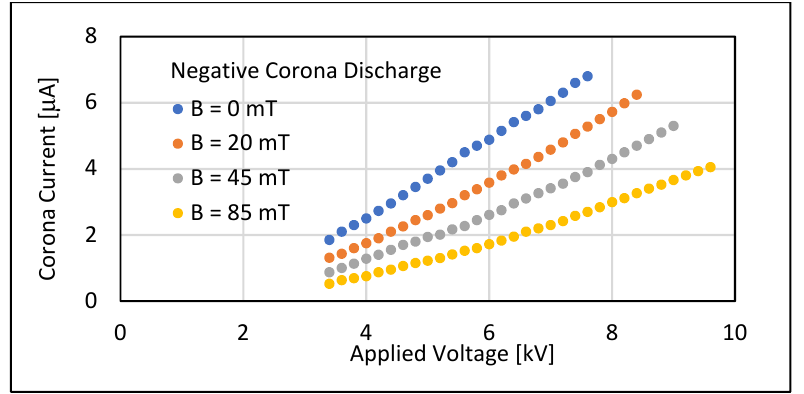
Figure 3. Current-voltage characteristic of positive corona discharge at different values of B. Figure 4. Current-voltage characteristic of negative corona discharge at different values of B.